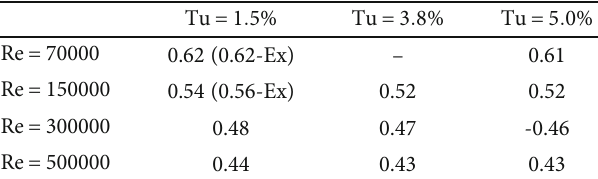
Table 6: Maximum δ ∗ positions ( x / L ) with D12-7.